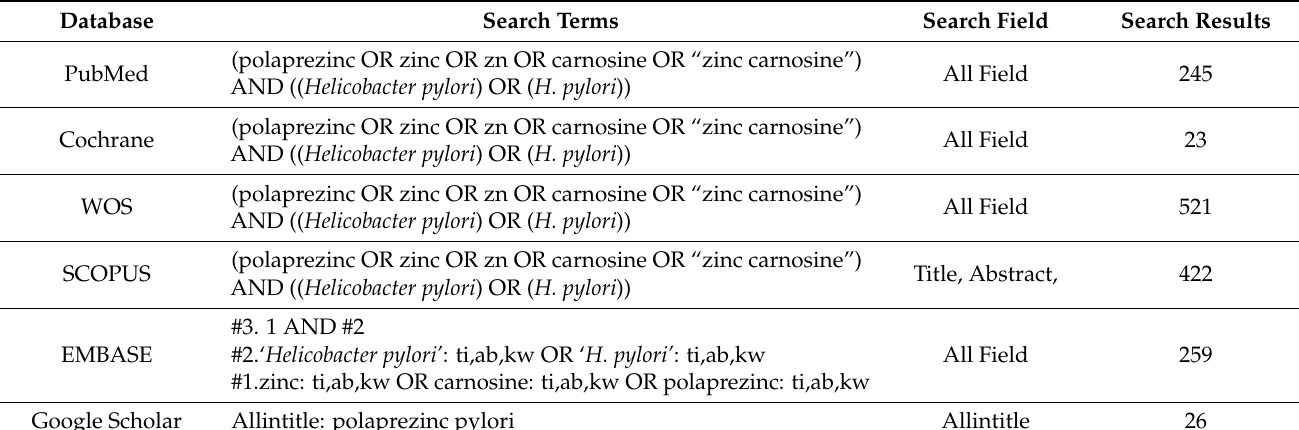
Table 1. Search terms and results in different